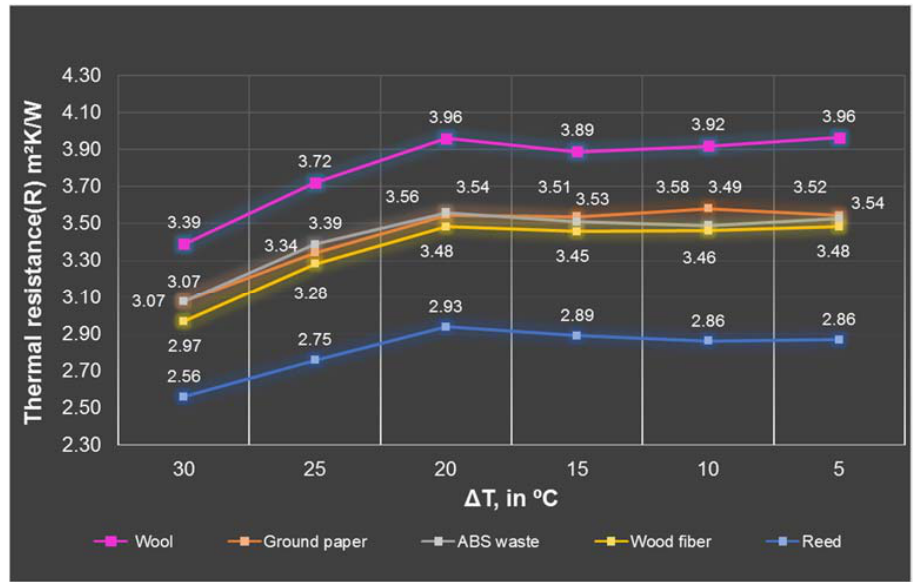
Figure 6. Comparison between thermal resistance values of investigated wall structures in the conditions of cold and warm season simulation, for different fillers.